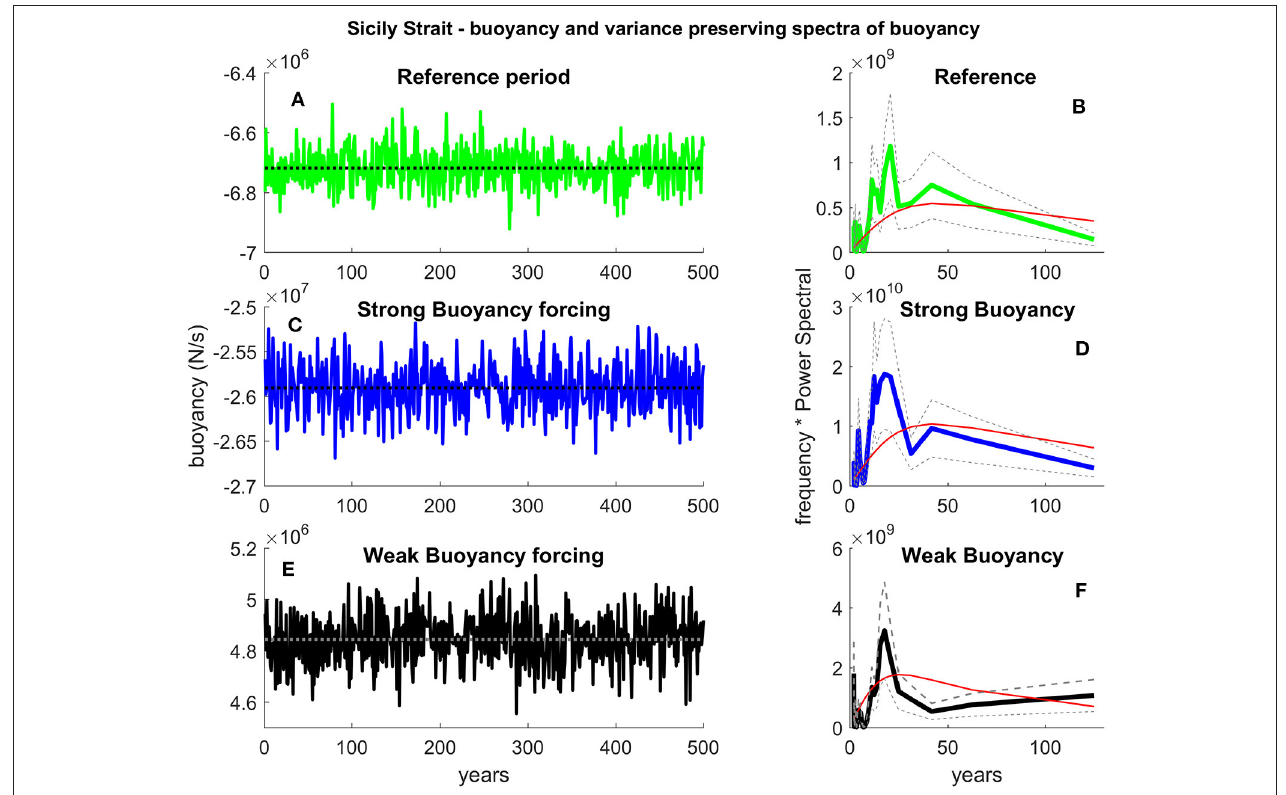
FIGURE 7 | (A–F) Transect-integrated buoyancy flux through the Sicily Strait (as in Figure 6 ). Positive values correspond to a northward buoyancy